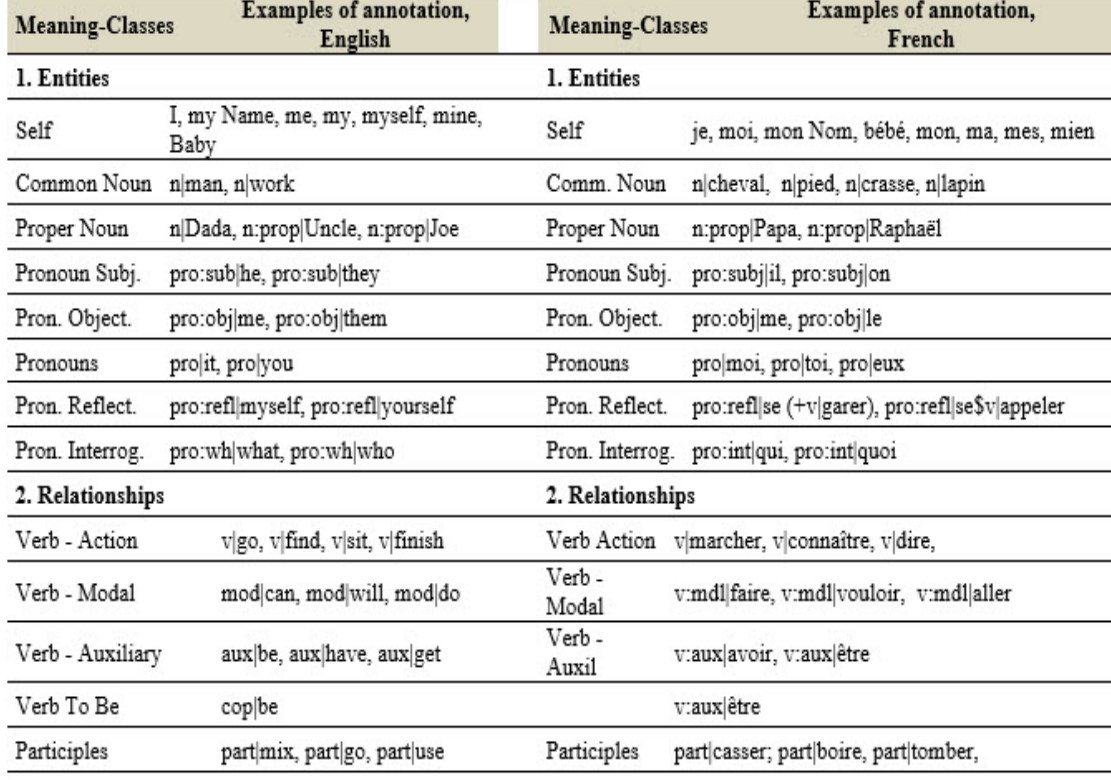
Table 3. Proposed meaning-classes in the model “Actor in the environment”. Spread of the POS with examples of